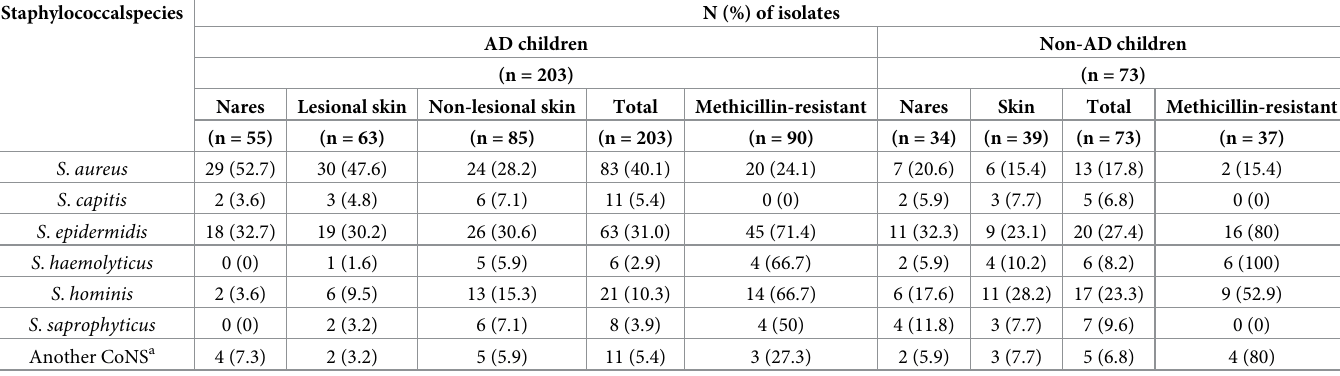
Table 1. Distribution of the staphylococcal isolates according to the species, isolation sites, and methicillin susceptibility.